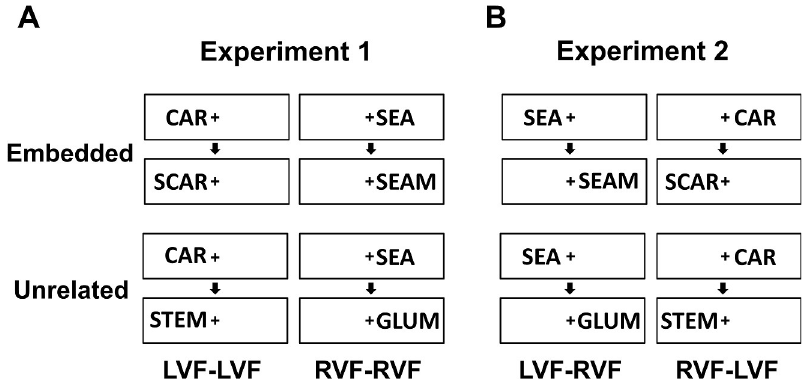
Fig 1. Stimuli and conditions in Experiment 1 and 2. In the embedded condition, the target repeats the primed embedded word and adds a letter to the prime; in the unrelated condition, the target shares no letter with the prime. (A) In Experiment 1, the prime either appears in the LVF or in the RVF, and the target always appears in the same hemifield as the prime. (B) In Experiment 2, the prime either appears in the LVF or in the RVF, and the target always appears in the opposite hemifield as the